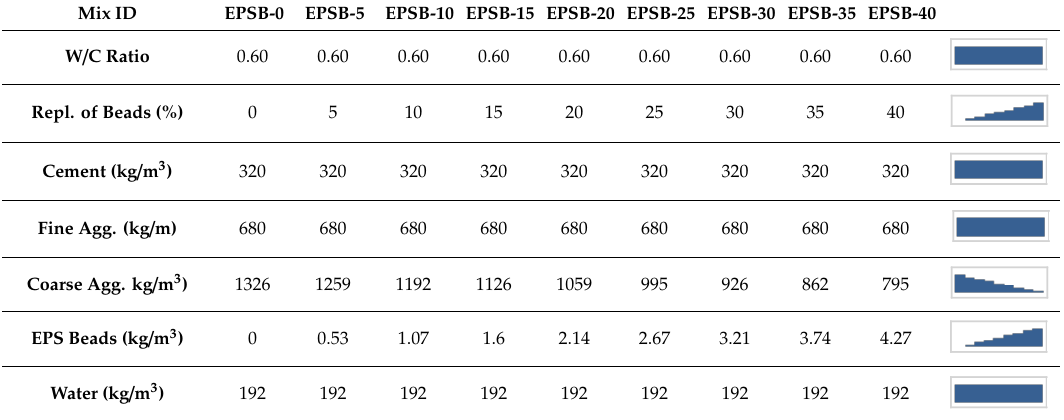
Table 6. Quantity mix proportion of an expanded polystyrene beads concrete.